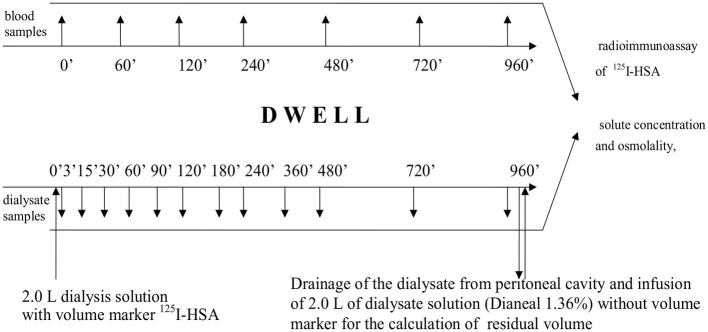
Protocol of the study.